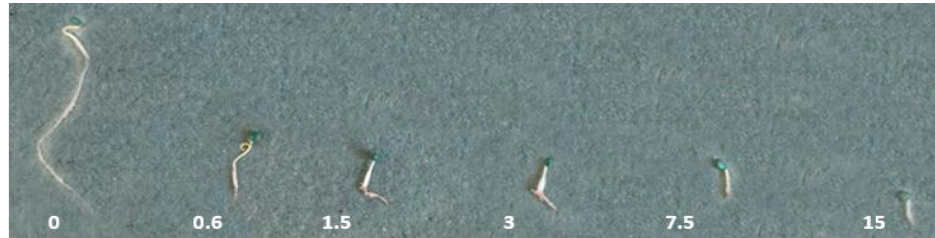
Figure 1. Deformation of germinating seeds in cultivar Start, 5 th day after sowing on the sand. From left: 0, 0.6, 1.5, 3, 7.5, and 15 g/ha of aminopyralid.